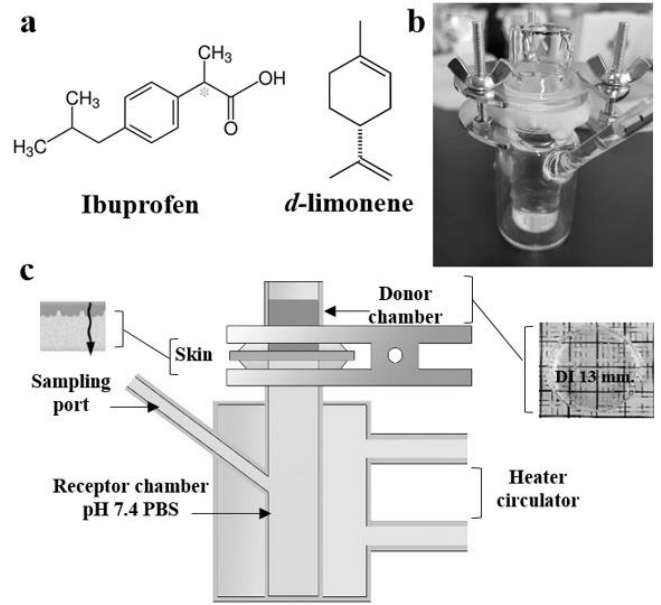
Figure 4. ( a ) Chemical structure of Ibuprofen as model drug and d-limonene, photograph of in vitro permeation experiment by using Franz diffusion cell ( b ) and illustration of permeation study ( c ). All PS gels swollen in limonene formulations show high potential releasing properties through the skin because limonene can enhance the permeation of the drug through the epidermis by increasing the activity of drug with SC or decrease the tortuous pathway in SC or both [14]. Nevertheless, the lack of solvent in PS-co-DVB would not be able to permeate drug in transdermal system. These exhibit the advantage of chemical organogel swollen in d-limonene could perform prolong release with simple preparation of cross-linked polystyrene. Permeability of drug from the PS gels swollen in limonene (Table 1, entry 1) was compared to the gel swollen in toluene (Table 1, entry 5) with the similar crosslinking condition (Figure 5a,e).